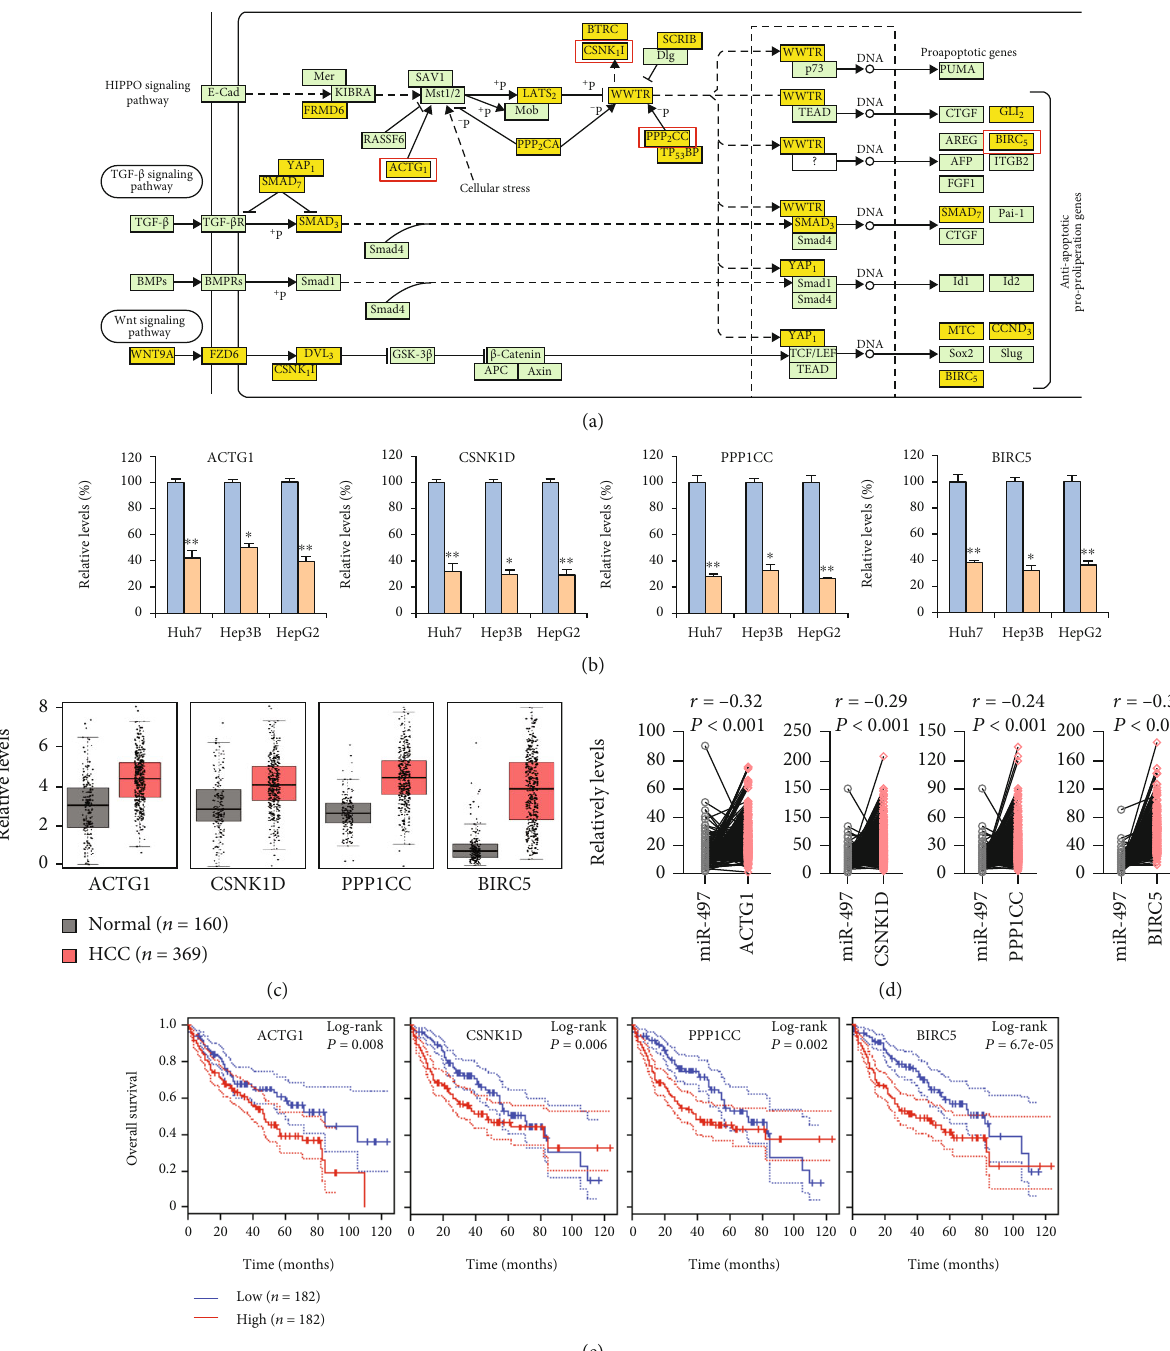
Figure 7: Association between miR-497-5p target gene expression and their clinical features with HCC prognosis. (a) miR-497-5p target prediction using online target gene prediction programs DIANA-miRPath, miRDB, miRTarBase, and miRanda for KEGG analysis of common predicted target genes. (b) qRT-PCR was used to measure the mRNA level of four predicted target genes ACTG1, CSNK1D, PPP1CC, and BIRC5 in Huh7, Hep3B, and HepG2 cells after transfection with negative control or miR-497-5p overexpression plasmids. (c) Expression levels of ACTG1, CSNK1D, PPP1CC, and BIRC5 in normal liver ( n = 160 ) and liver cancer ( n = 369 ) samples from the GEPIA dataset. (d) Correlation of miR-497-5p expression levels with target genes ACTG1, CSNK1D, PPP1CC, and BIRC5 in liver cancer samples ( n = 369 ) from the TCGA dataset. (e) Kaplan-Meier survival analysis to evaluate the prognostic value of ACTG1, CSNK1D, PPP1CC, and BIRC5 expression for OS of HCC patients from the TCGA dataset. Statistical analyses were performed with one-way ANOVA ( ∗ p < 0 : 05 and ∗∗ p < 0 : 01